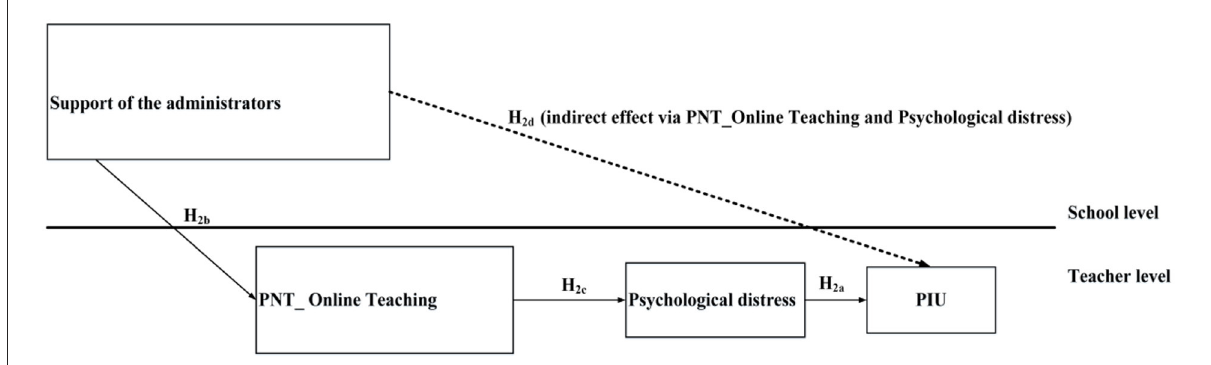
FIGURE2 Framework of the cross-level serial mediation model; all variables were assessed at Time 1, including administrator support, psychological need thwarting of online teaching (PNT_Online Teaching), psychological distress, and two forms of problematic internet use (PIU): problematic social media use and problematic